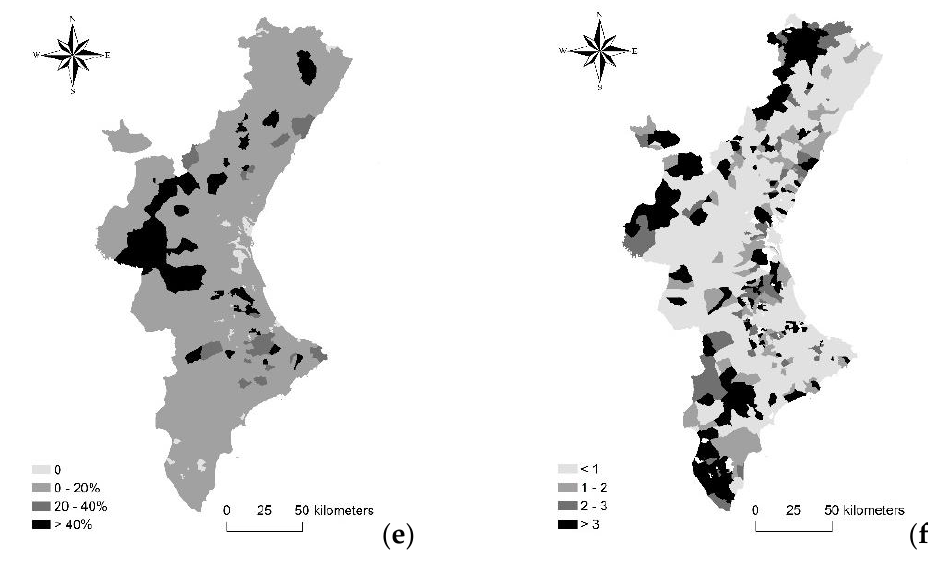
Figure 2. Burned and not-burned areas ( a ); number of times when a fire occurs at the same location (insert highlights the most exposed area) ( b ); time series of fires per year ( c ); duration of fires (in days) in the last years ( d ); burnt surface in municipal surface area ( e ); and the ratio of number of fires to burnt areas ( f ).